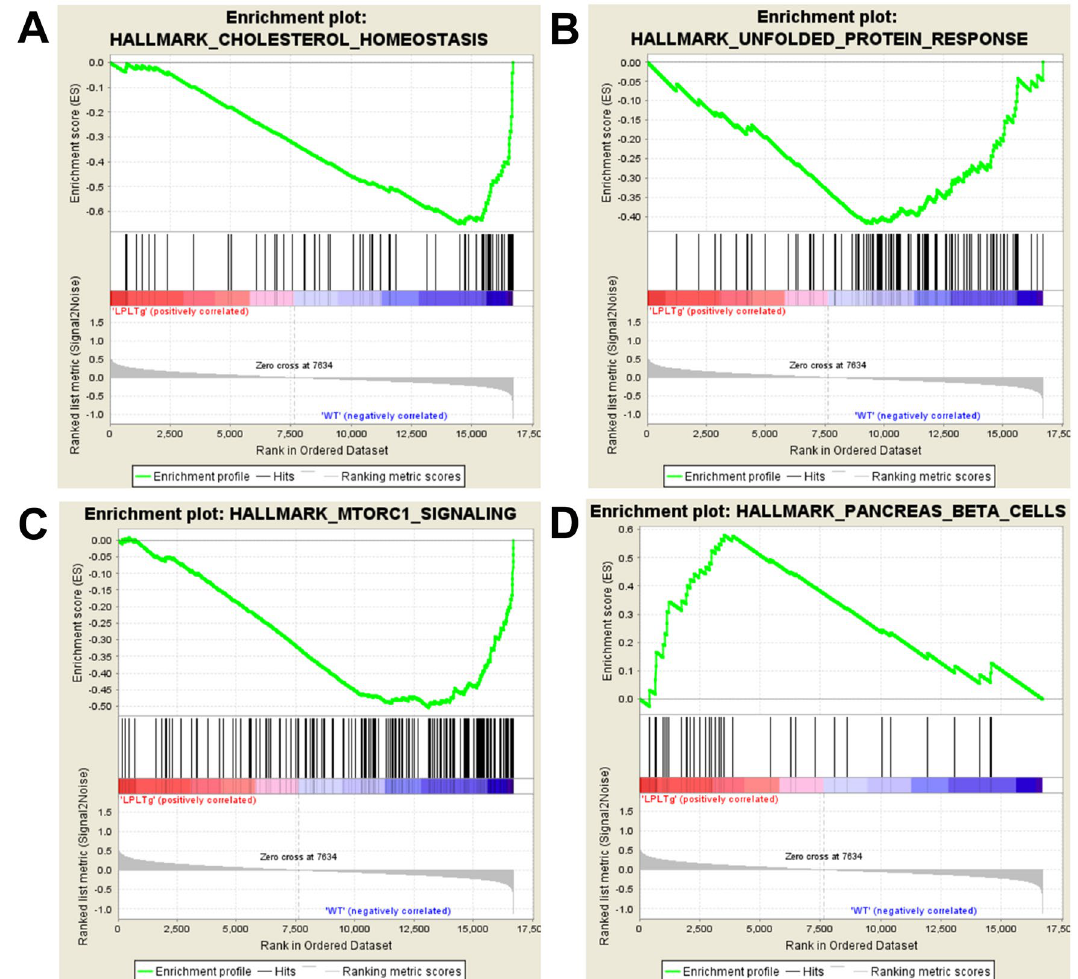
Figure 1. Enrichment plots of hallmark gene sets enriched and repressed in perigonadal adipose tissue of male AdipoQ-LPL mice. We used Affymetrix Mouse 2.0 microarrays to quantify gene expression in perigonadal adipose tissue and analyzed the entire set of data by gene set enrichment analysis to identify hallmark gene sets enriched or repressed in the AdipoQ-LPL mice (n = 12). ( A – D ) Enrichment plots for gene sets repressed and enriched in AdipoQ-LPL